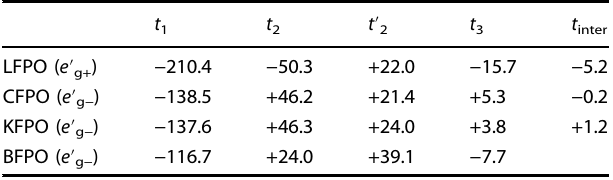
t 3 and t inter are the third-nearest-neighbor and the largest interlayer hopping terms,